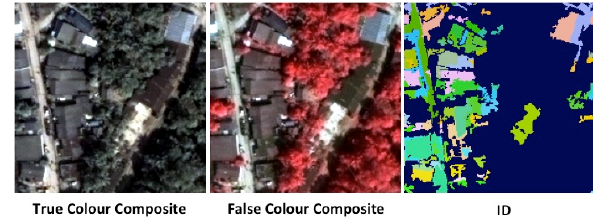
Figure 7. Difficult situation for automated